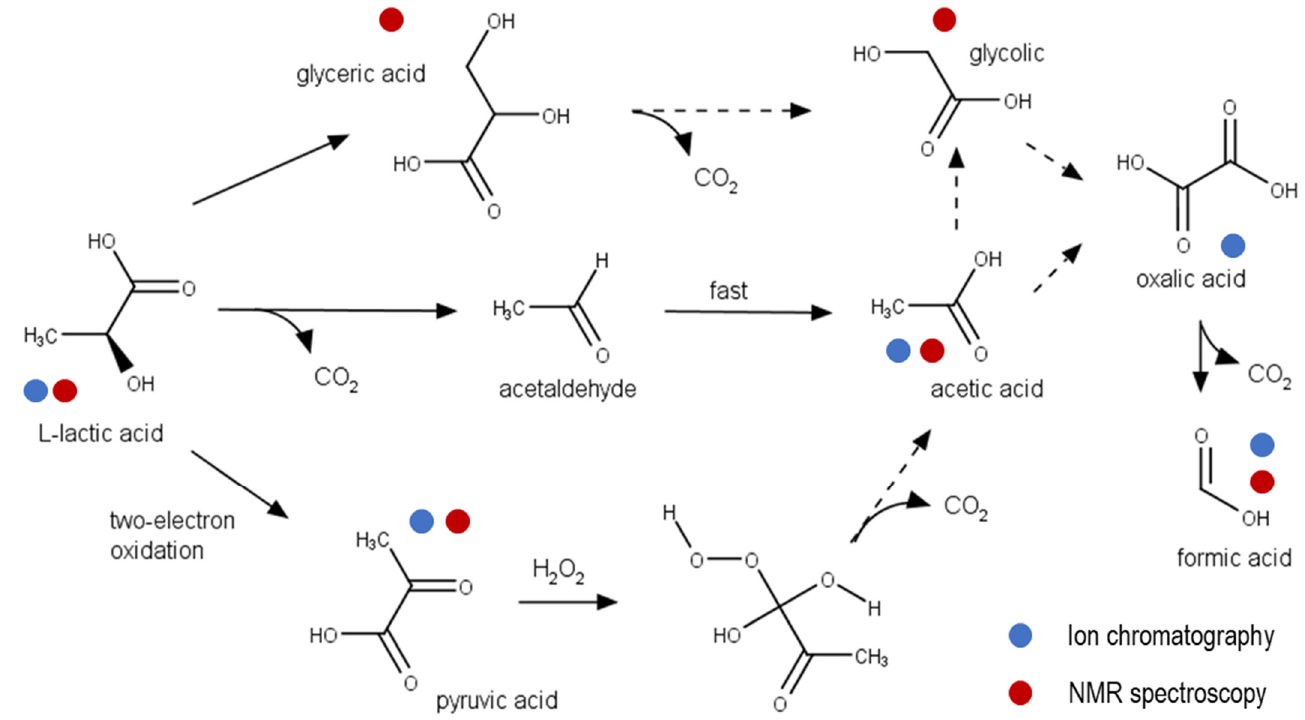
Figure 5. Reaction schematic of gas plasma oxidation of Ringer’s solution’s main constituent, lactate, reveals acetate and carbon dioxide as major products. The decarboxylation of lactate yields acetaldehyde that is immediately oxidized to acetic acid. In parallel, one-electron oxidations yield pyruvic acid, which reacts with deposited H 2 O 2 , yielding acetic acid again. Minor side reactions via glycerate and glycolic acid occurred. Terminal oxidation via oxalate and formic acid yield carbon dioxide as the ultimate product.